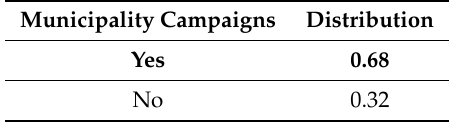
Table 5. Overall distribution of the categorical variable “municipality